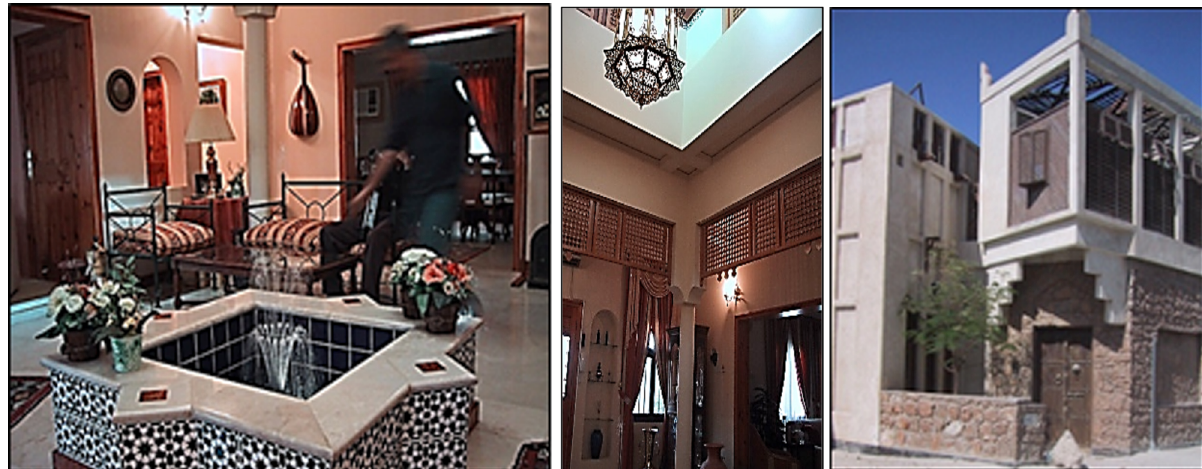
Fig. 10. Architect Ahmed Al Jowader built his house in the Hidd area (Bahrain) to contain a wind tower and a courtyard adapting traditional materials to modern use as well as save a massive amount of